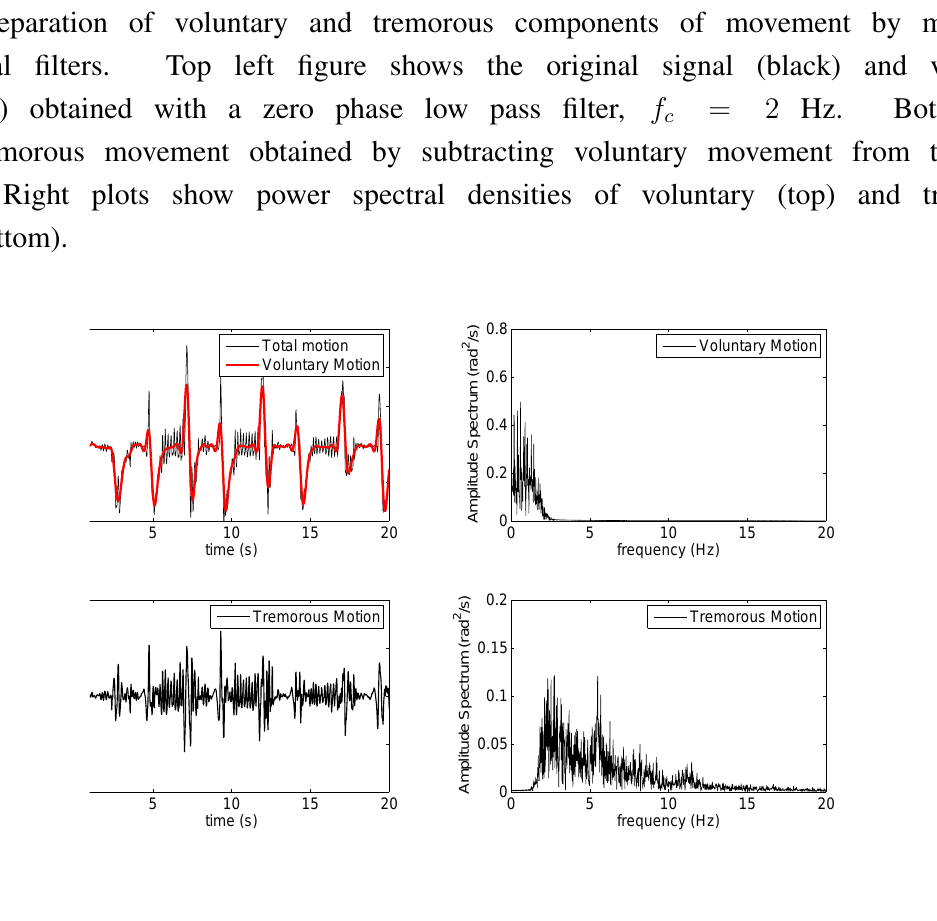
= 2 Hz. Bottom left c